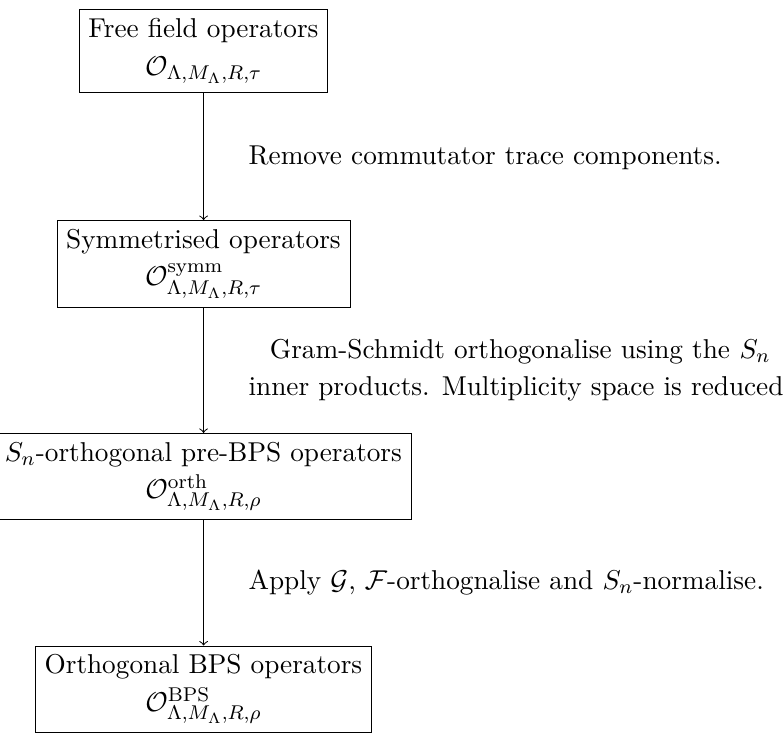
derived Λ ,M Λ ,p,ν